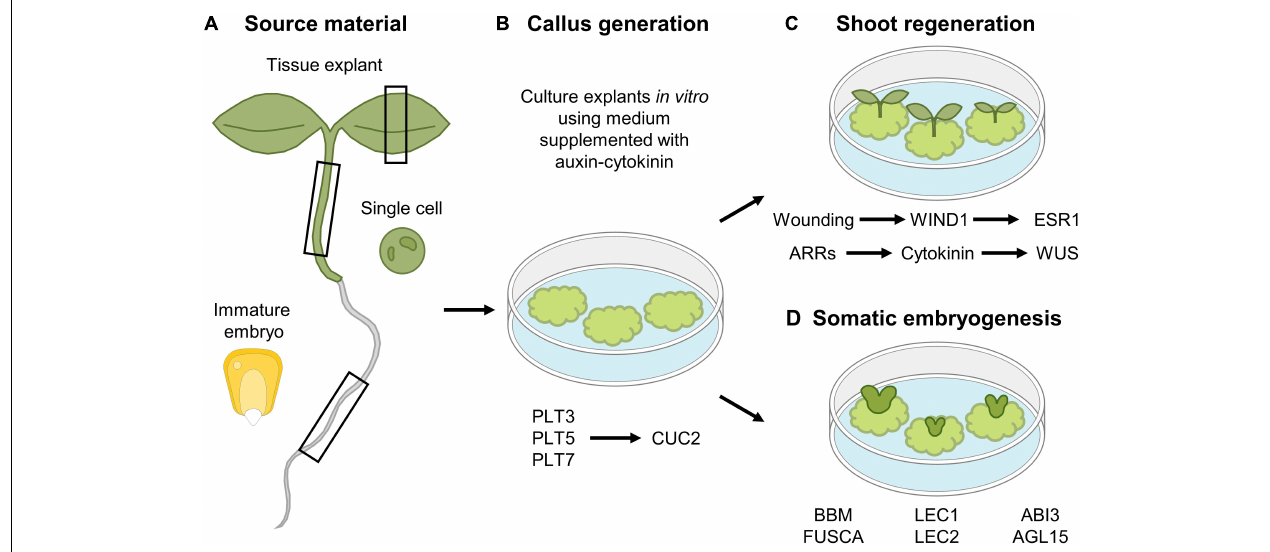
FIGURE 4 | In vitro tissue culturing using (A) various tissue explants to (B) generate callus and subsequent (C) shoot regeneration or (D) somatic embryogenesis. (A,B) Different tissue explant material can be used for in vitro callus generation, including leaf, hypocotyl and root explants, immature maize embryos and single cultured cells. (C) Shoot regeneration occurs in a two-step mechanism, where callus is first generated by the action of the PLT3, PLT5, and PLT7 transcription factors, whereas in a second step, expression of CUC2 is required for shoot induction. In parallel, a new shoot organizing center is established by the action of ARRs that facilitate cytokinin production, that in turn activates WUS expression. In addition, wounding-induced expression of WIND1 allows in turn induction of ESR1 that contributes to regeneration of shoots. (D) Somatic embryogenesis from callus occurs by the expression of a network of transcription factors, composed of BBM , LEC2 , FUSCA , ABI3 , and AGL15